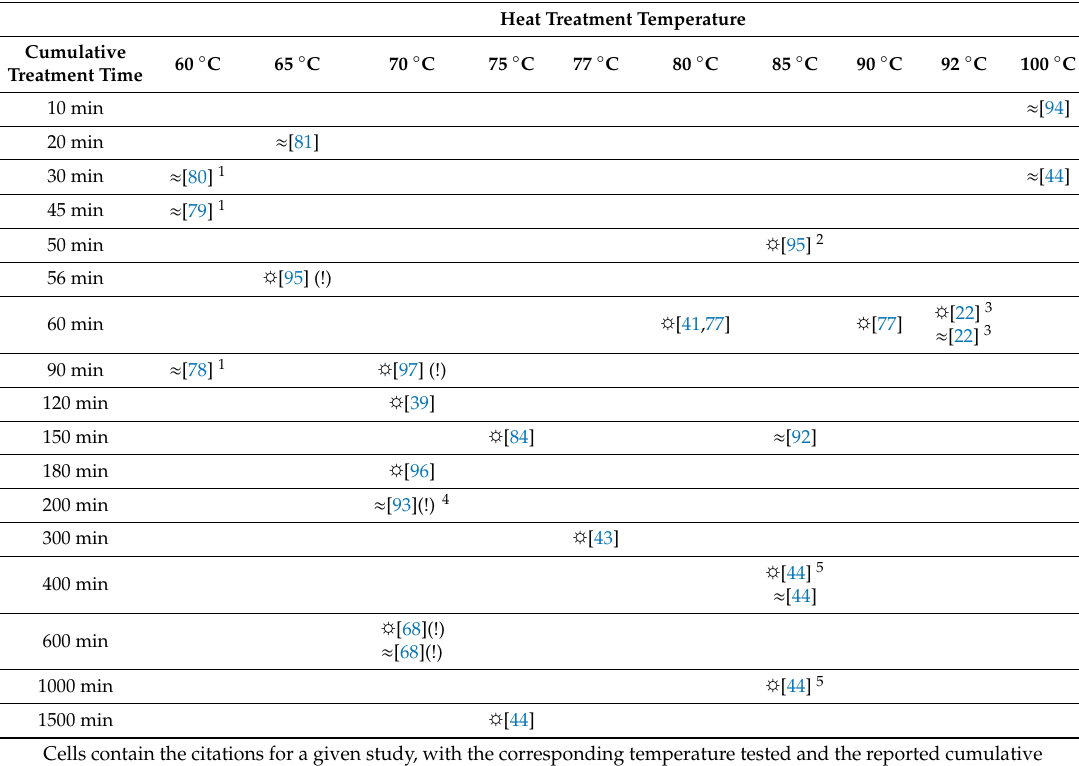
Table 8. Summary of findings from the studies reporting on the e ff ects of dry heat treatment ( moist heat treatment ( ≈ ) on filtering facepiece respirators